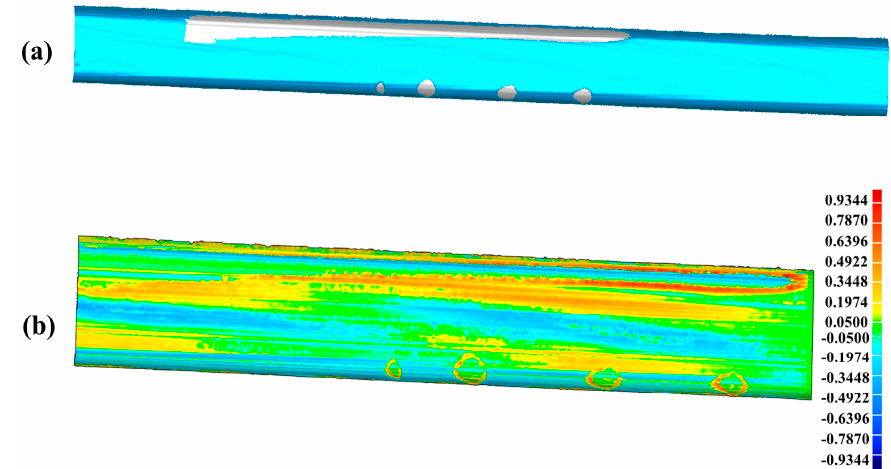
Figure 23. The accuracy analysis of the scratch-data acquired in the experiment for the artificial damaged rail. ( a ) The result of virtual repair of the artificial rail by using the scratch-data; ( b ) The difference between the repaired artificial rail model and the reference model indicating the scratch-depth on the repaired artificial rail is less than 1 mm. Table 10. The analysis result of the repaired artificial rail.